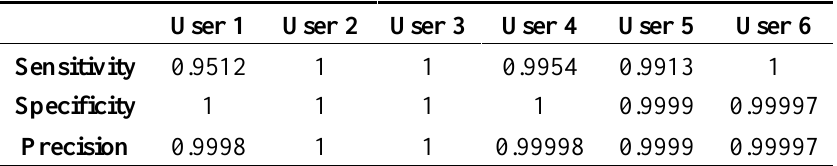
Table 6. Statistics results